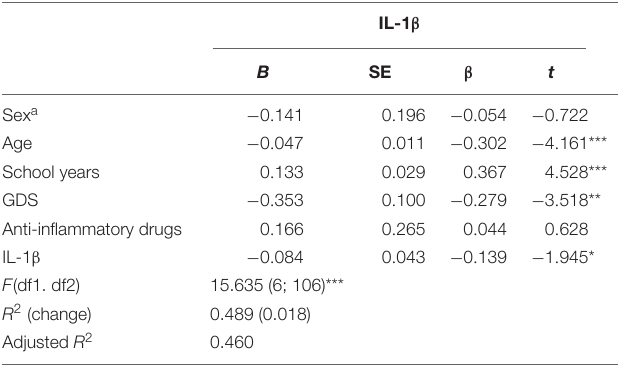
TABLE 2 | Linear regression models to explain the variance of general and executive function